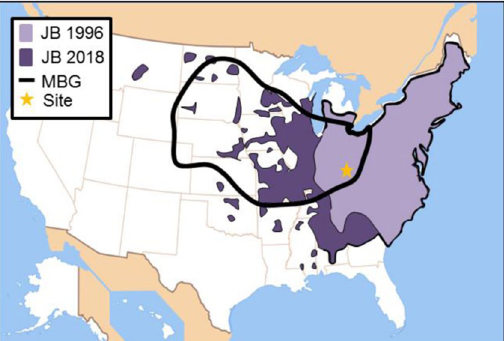
Figure 1. Japanese beetle [JB] incursion into the monarch butterfly breeding grounds [MBG] of the US Midwest. JB distributions are based on USDA APHIS Cooperative Agricultural Pest Survey maps (19) . Light purple denotes areas occupied by JB in 1996; dark purple denotes additional areas where JB had become established by 2018. Black line encloses the geographic region of the United States that is estimated, based on stable isotope analysis and geospatial modeling, to have produced the highest proportion of monarchs overwintering in Mexico over a 38-year period from 1976–2014 20 . Star represents the location where the research described herein was conducted.